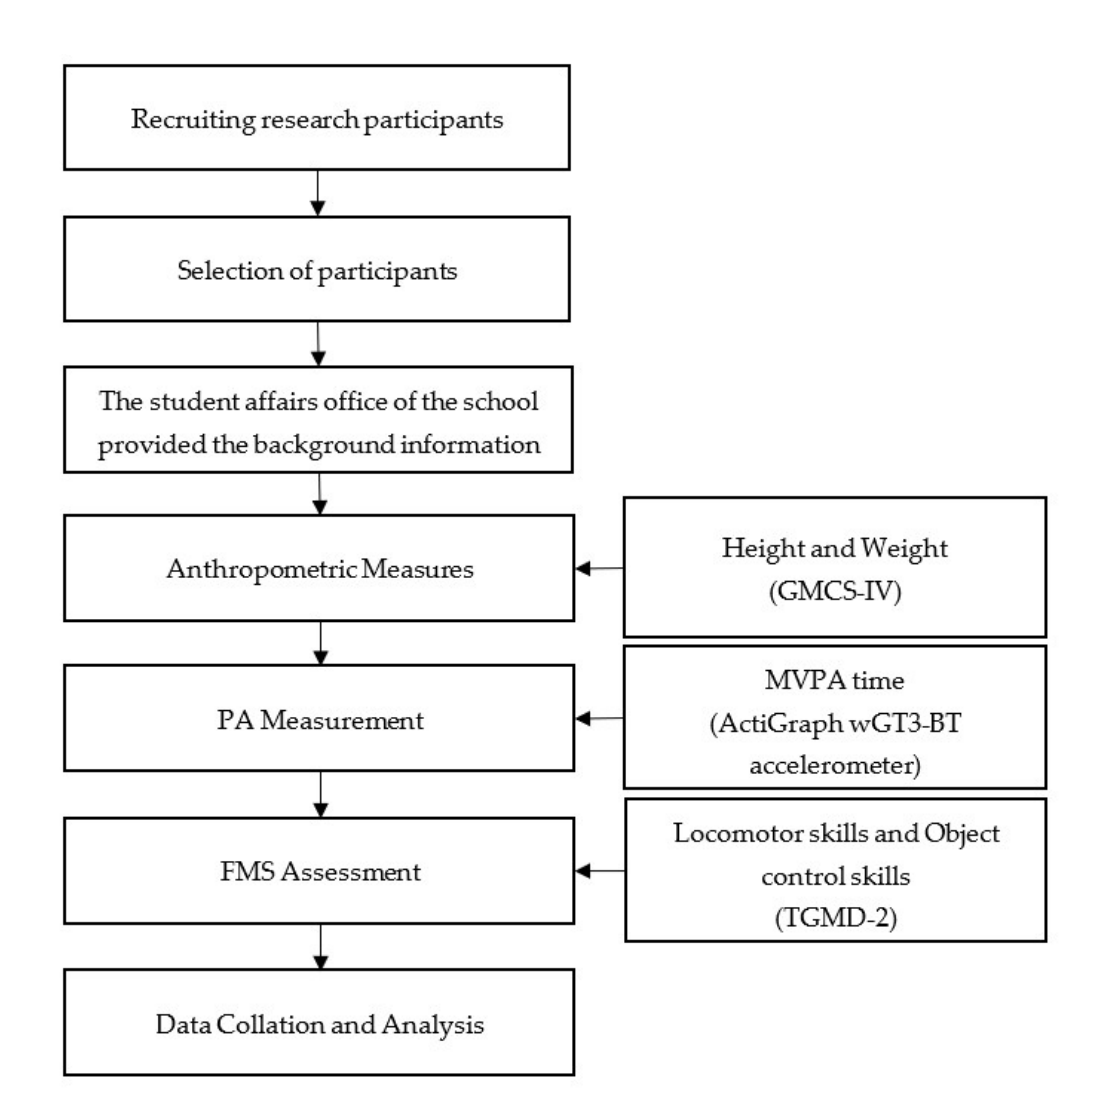
Figure 1. Study flow chart. Note: FMS, fundamental movement skills; MVPA, moderate-to-vigorous intensity physical activity; PA, physical activity.